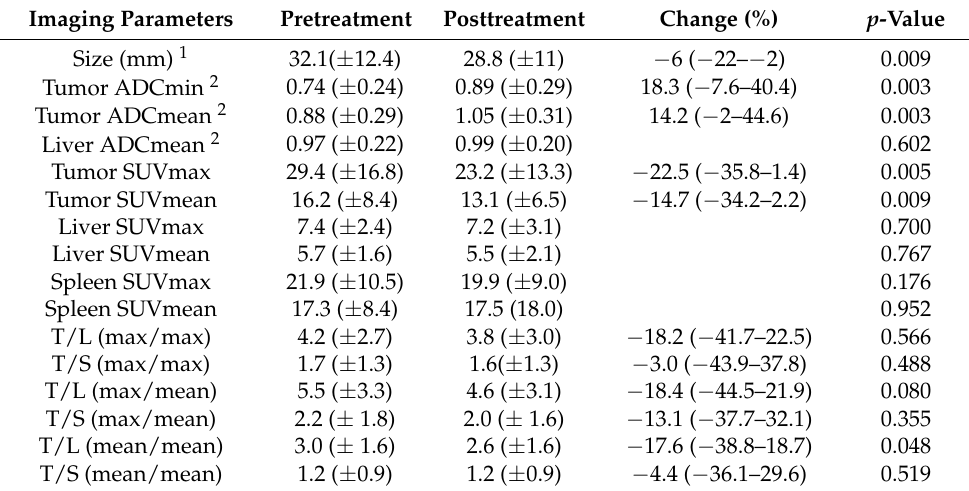
Table 3. Pre- and postinterventional imaging parameters.